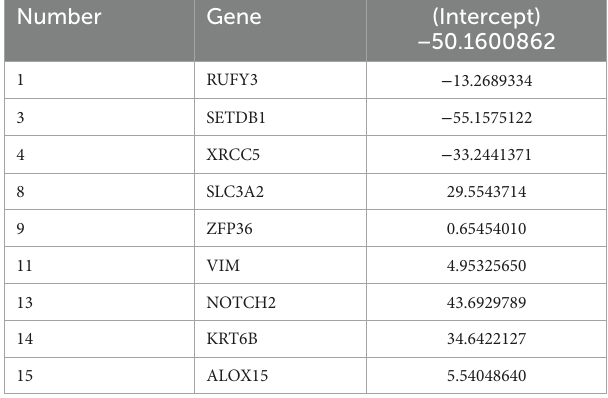
TABLE 3 List of weight